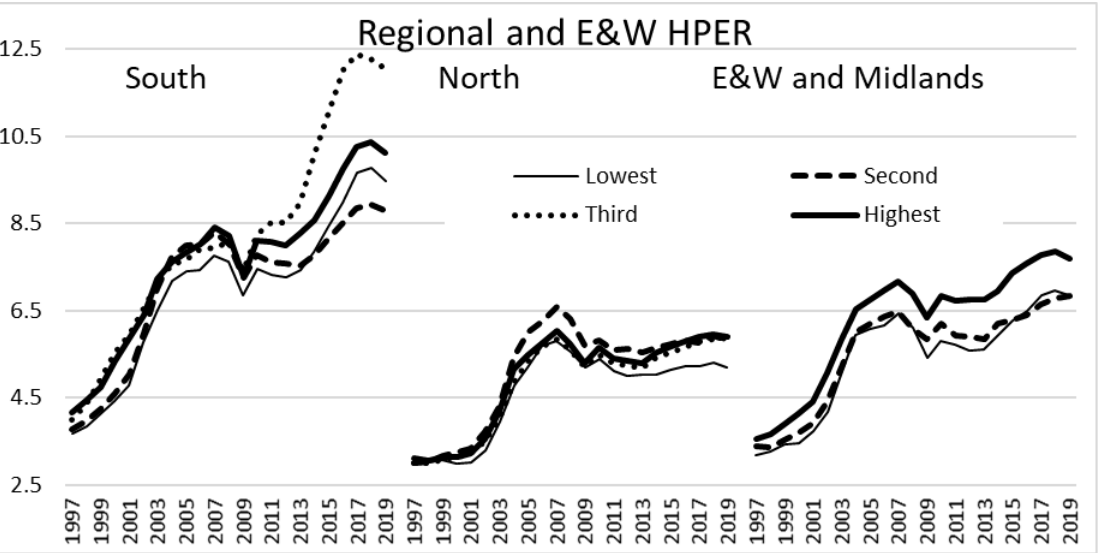
Figure 1. Regional House Price Earnings Ratio. South — Lowest: East of England < South West < London < Highest: South East; North — Lowest: North East < Wales < North West < Highest: Yorkshire-Humberside; E&W and Midlands — Lowest: East Midlands < West Midlands < Highest: E&W.